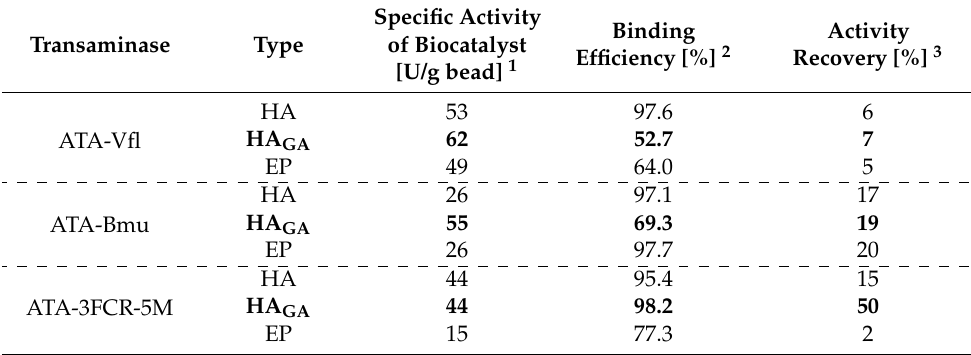
Table 1. Specific activity, binding efficiency, and activity recovery of immobilized transaminase on solid supports. The best immobilizates of the transaminases on solid support are defined as immobilizates with the highest activity (U/g bead) and are highlighted in bold. Activity recovery was determined as indicated in the Supplementary Materials, where also the complete and detailed immobilization parameters can be found (Table